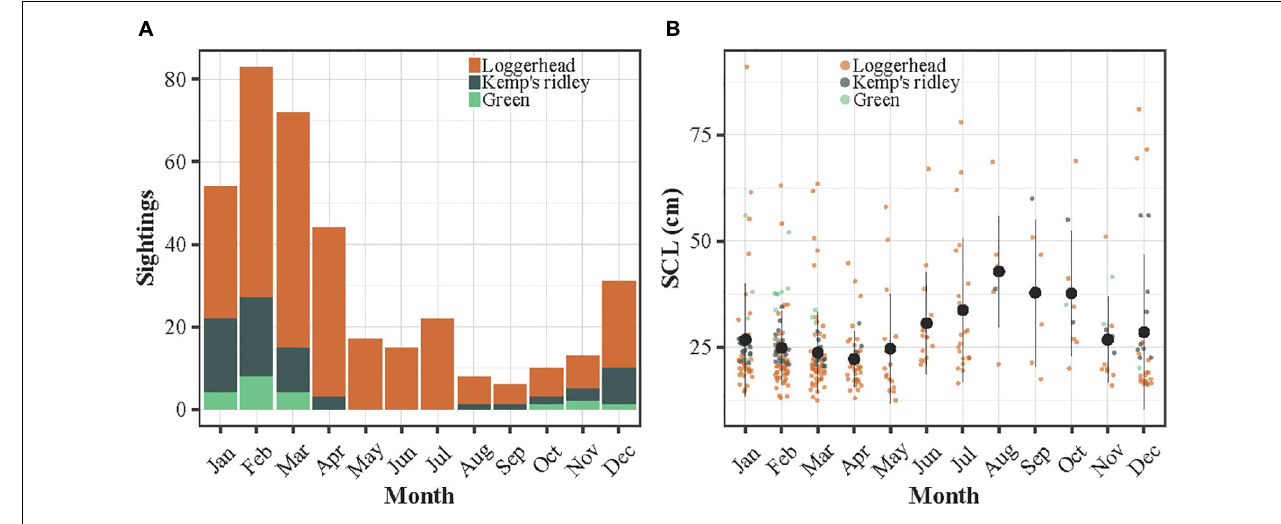
FIGURE 2 | (A) Histogram of the number of sightings according to month and species. (B) Distribution of the SCL (SCLmin or SCL in cm) of the sightings over month. In (B) , the dots refer to the monthly means and the bars to the standard errors.